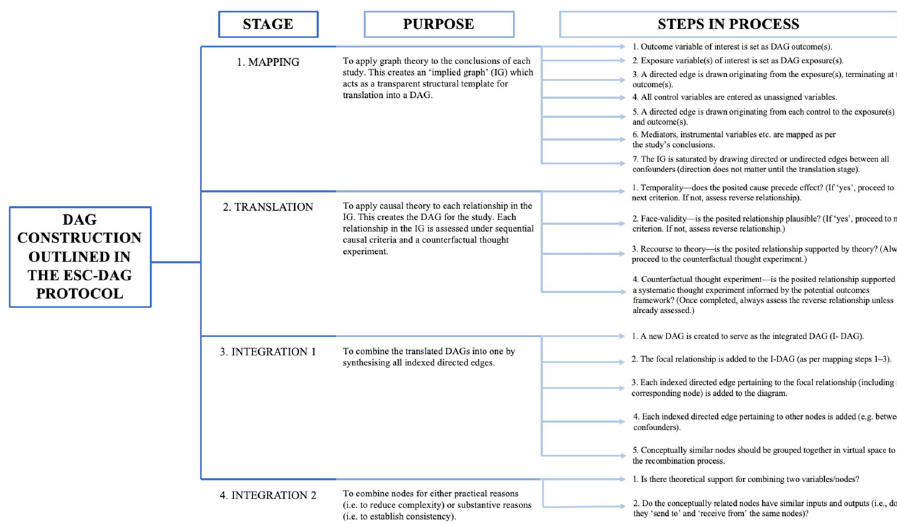
Fig 3. Stages, purpose, and the steps of DAG construction outlined in the ESC-DAG protocol [11] that the reviewers scored the final papers against. IG: implied graph (a DAG that acts as a structural template to build the